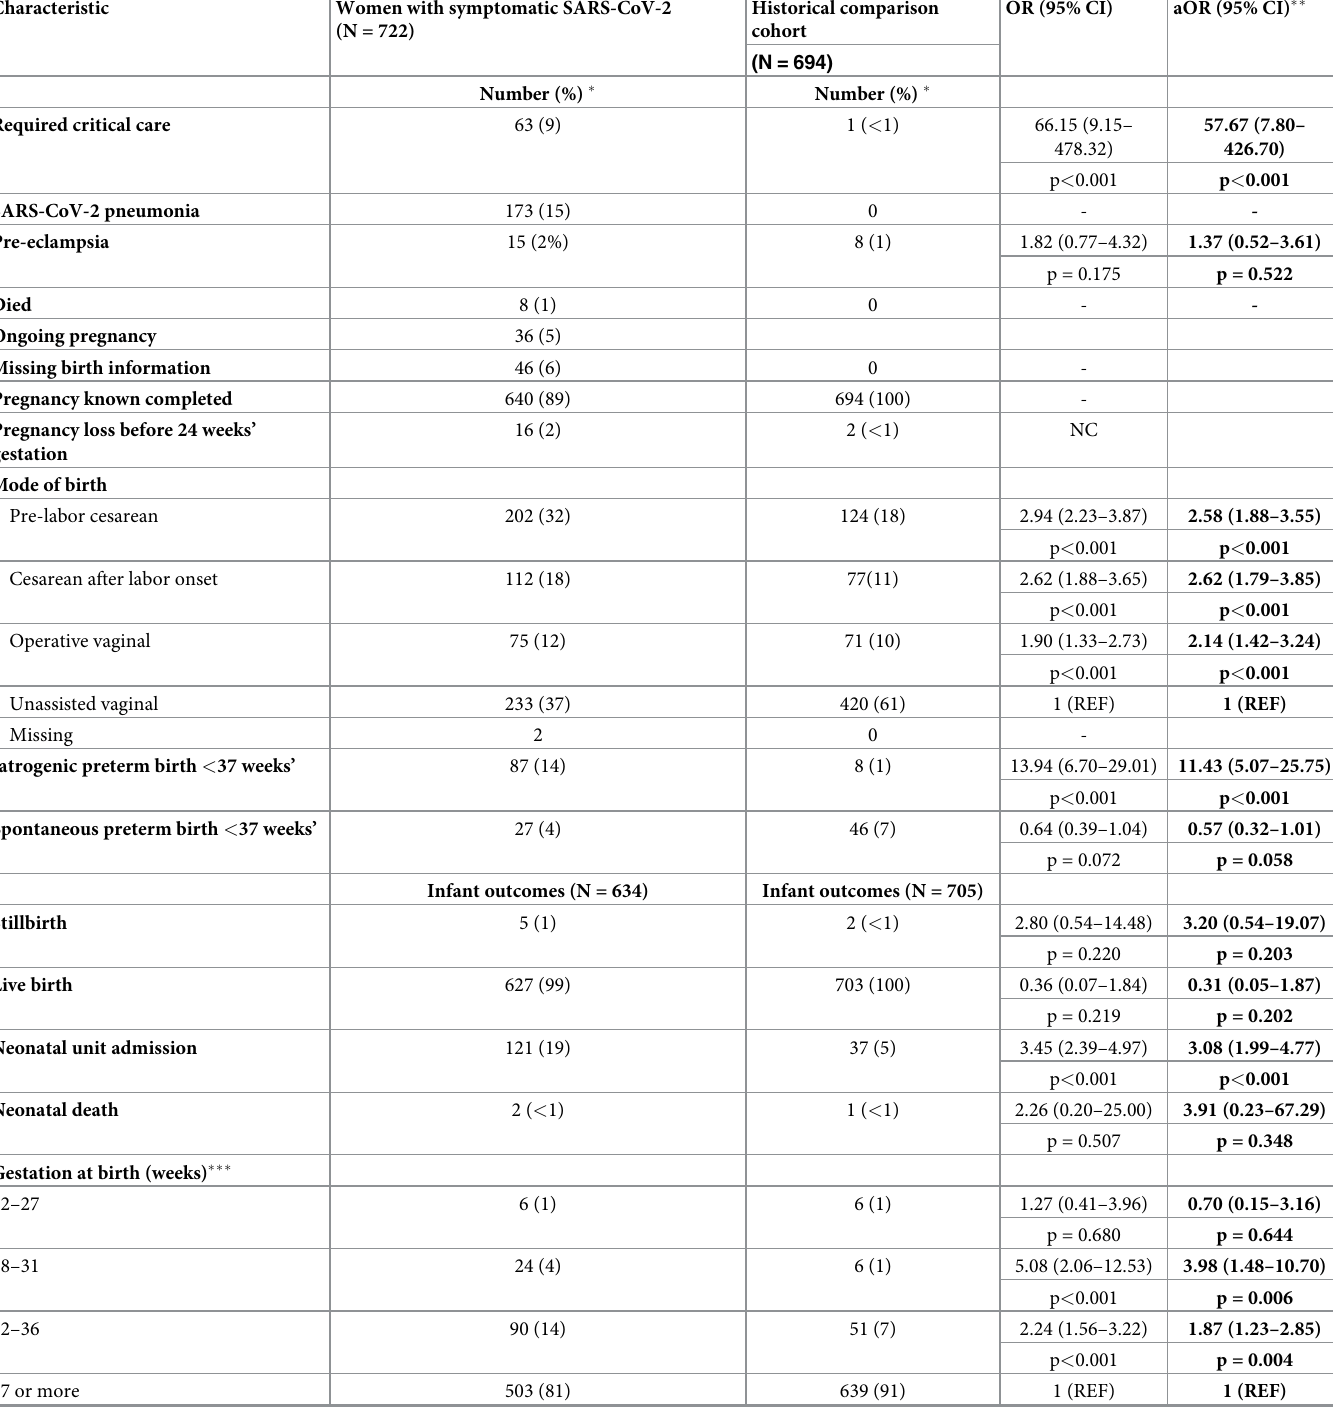
Table 3. Pregnancy and infant outcomes for pregnant women with symptomatic confirmed SARS-CoV-2 infection hospitalized in the UK compared to a historical cohort without SARS-CoV-2